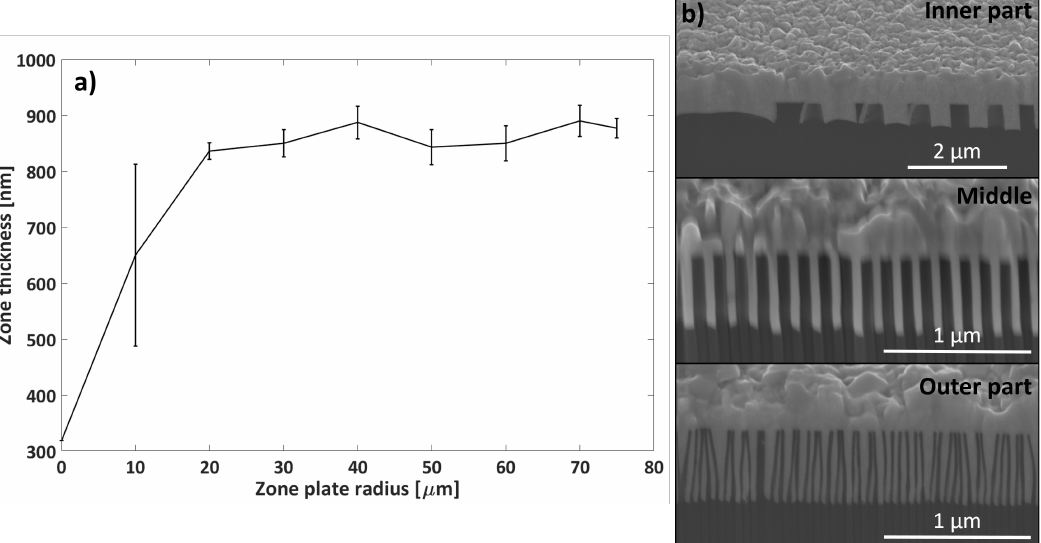
Figure 3. ( a ) Zone thickness profile over the zone plate radius based on image analysis of SEM cross-section micrographs. The error bars represent the zone thickness variation of the surrounding zones at each point. ( b ) SEM micrographs of the cross-sections of the inner, middle, and outer parts of a typical Pd/Si zone plate (52 ◦ -tilt